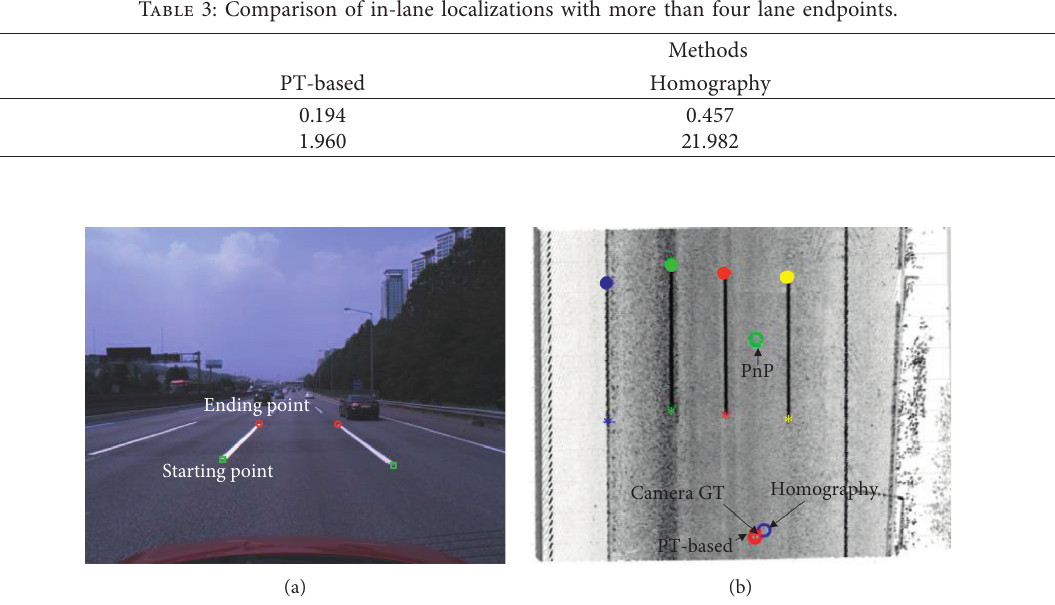
Figure 11: Comparison of the estimated camera positions: (a) detected lane endpoints; (b) estimated camera